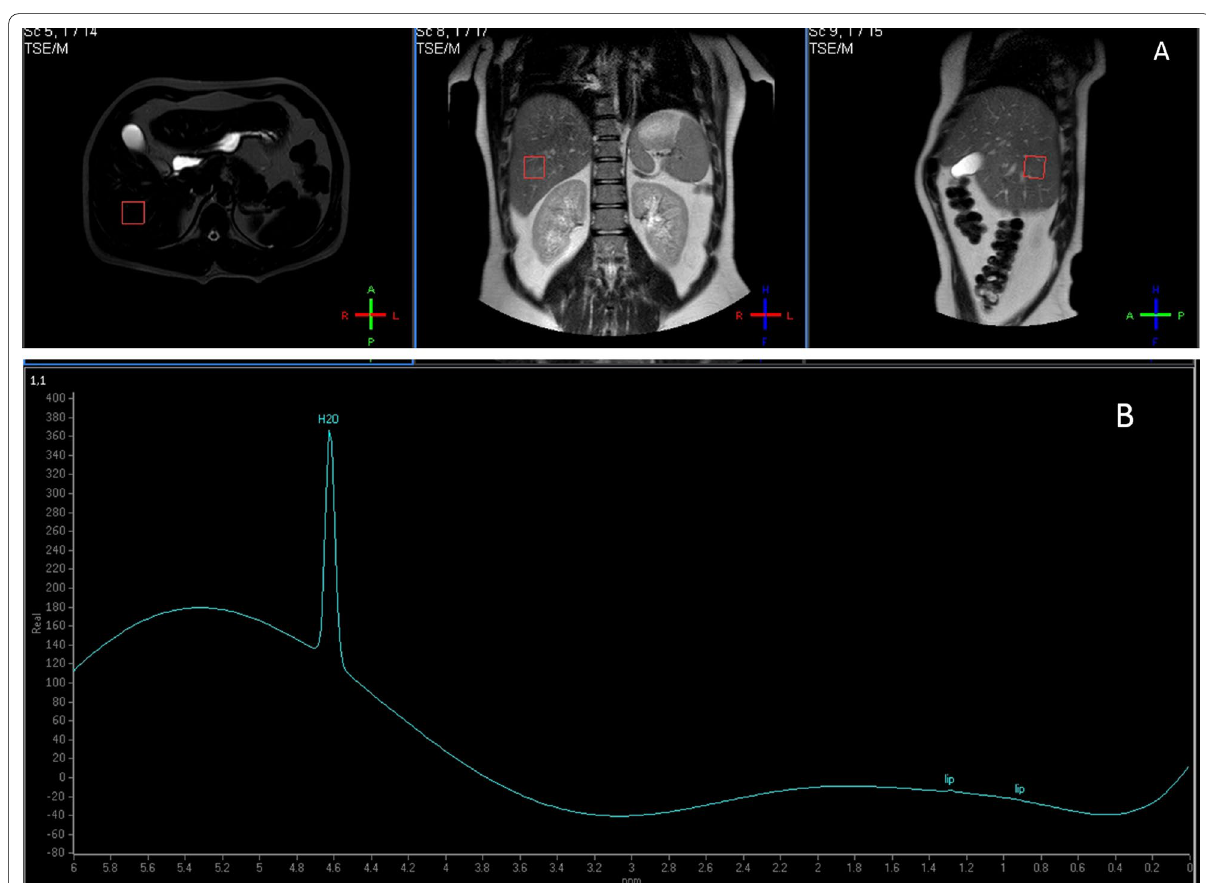
Fig. 4 Multiple 1H-MRS of different patients with CHC. A Localizer three plane images of 1H-MRS show a voxel located at segment VI of the right hepatic lobe. B non-steatosis, C mild steatosis spectrum, and D severe steatosis spectrum show lipid peaks at 0.9–1.3 ppm and H2O peak at 4.7 ppm. These spectra show reduced water peak with increase